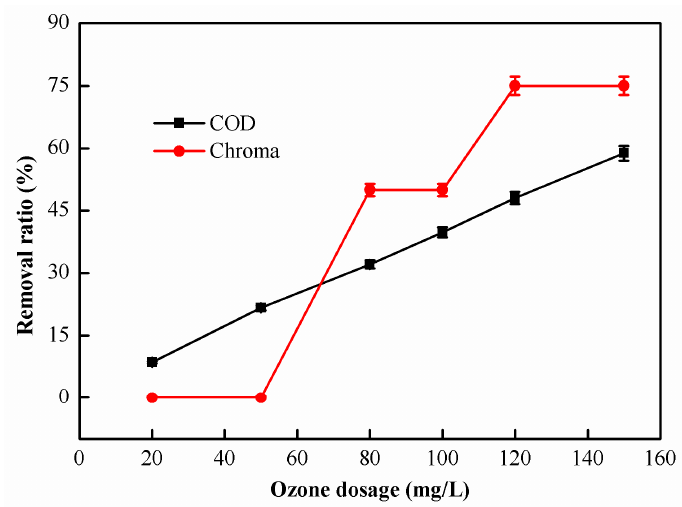
Figure 8. Effect of O 3 dosage on catalytic oxidation performance.